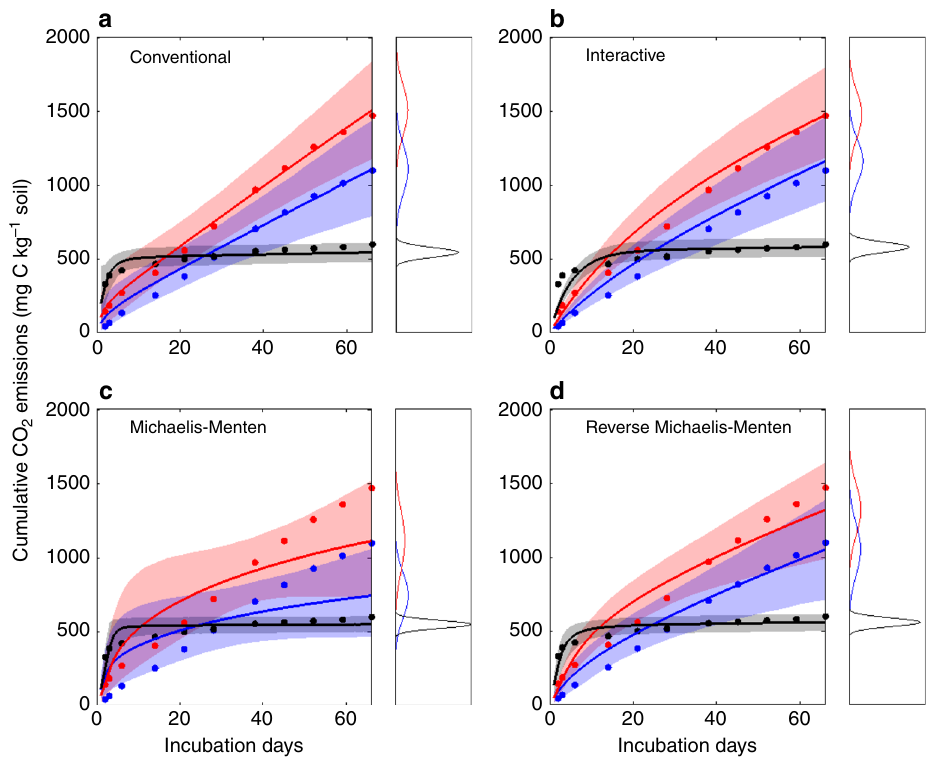
Fig. 3 An example showing the performances of different models in simulating cumulative CO 2 emissions from old and new C substrates. Dots and lines are observations and model simulations, respectively. Shading areas are the simulated ranges from 2.5th to 97.5th percentiles (i.e., 95% range). Blue and red, CO 2 emissions from old C at the control and new C addition treatments, respectively; Black, CO 2 emissions from added new C. The distributions of model-simulated cumulative CO 2 emissions at the end of experiment are also shown in each